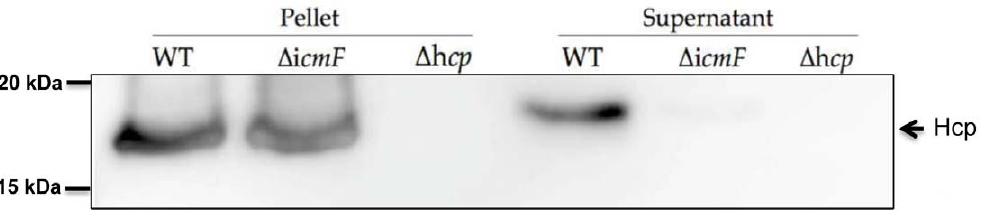
Figure 2. Western blot analysis of Hcp in WT C.jejuni , the D hcp mutant, and the D icmF mutant. Equal numbers of WT, D hcp and D icmF mutants were collected (see Material and Methods ). Pellet and supernatant were separated and used in immunoblot assays with an anti-Hcp antibody. The estimated molecular weight of Hcp is 18 kD. The results are representative of three independent experiments.